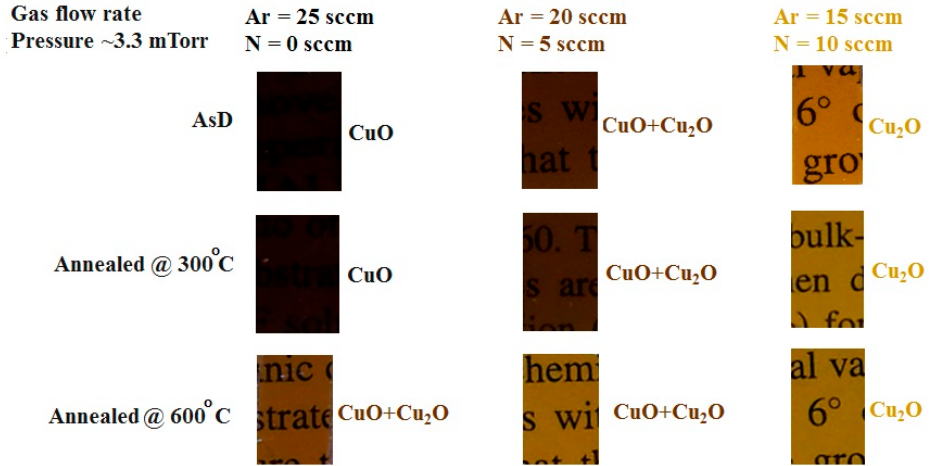
Figure 12. Tuning of film color and optical transmittance through in situ nitrogen doping for sputter grown CuO and Cu 2 O thin films. For each deposition condition, thermal annealing modifies film color and transmittance. The wider band gap of Cu 2 O results in higher transmittance as shown by the printed characters beneath these films.